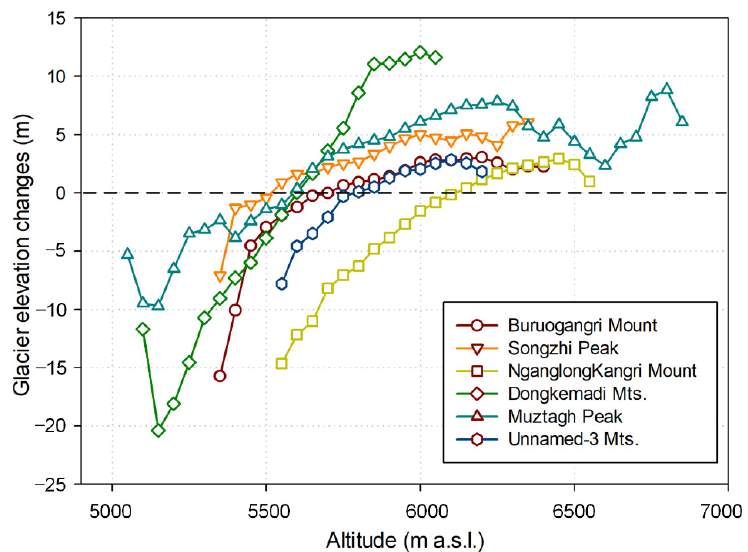
Figure 7. Glacier elevation changes versus altitude for the six study sites completely covered by X- band SRTM DEM (See Figure 1, red rectangle areas).